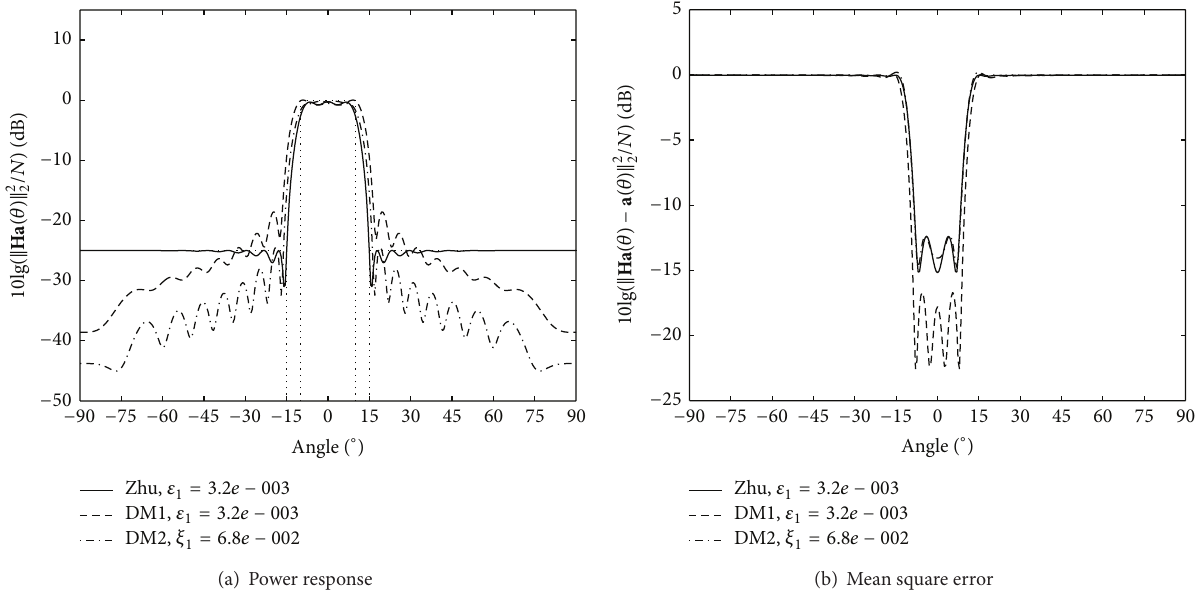
Figure 3: The comparison of Zhu method [8] with DM1 and DM2.